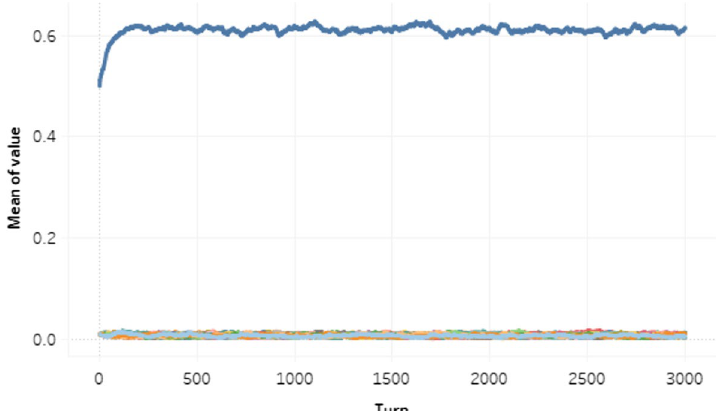
Fig. 2 The basic case: Time series change of the mean of view. Blue line is the fiat money good, red line is the cryptocurrency good, and other colors represent remaining goods. The fiat money good maintains a high value from beginning to end, indicating that the monetary function is